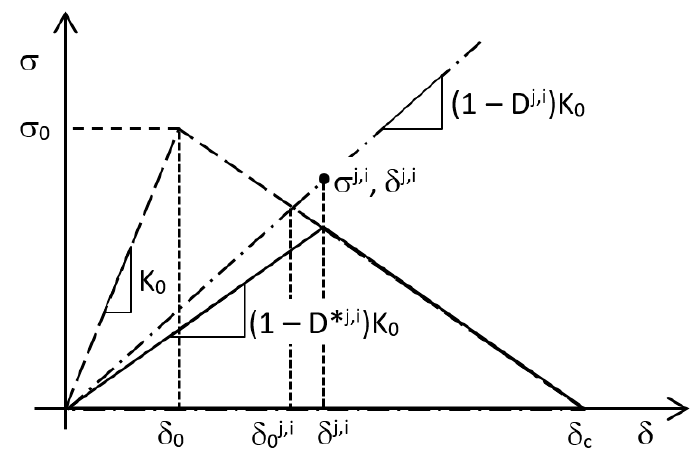
Figure 10. Outline of the definition of D* j .